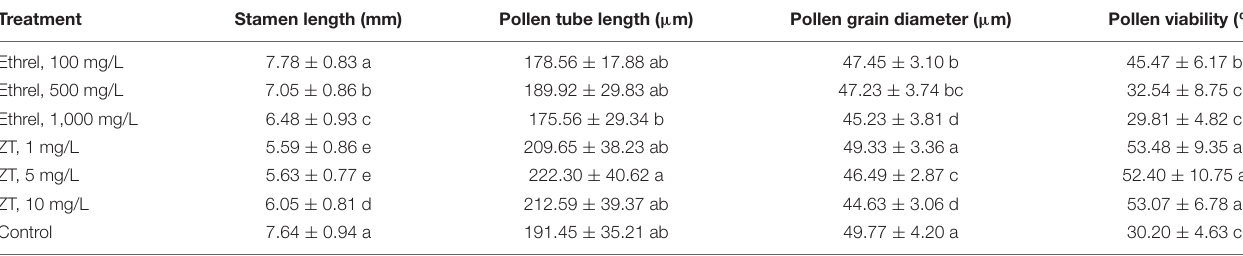
TABLE 2 | Effects of exogenous ethrel and ZT on flower traits in androecious persimmon. Treatment Stamen length (mm) Pollen tube length ( µ